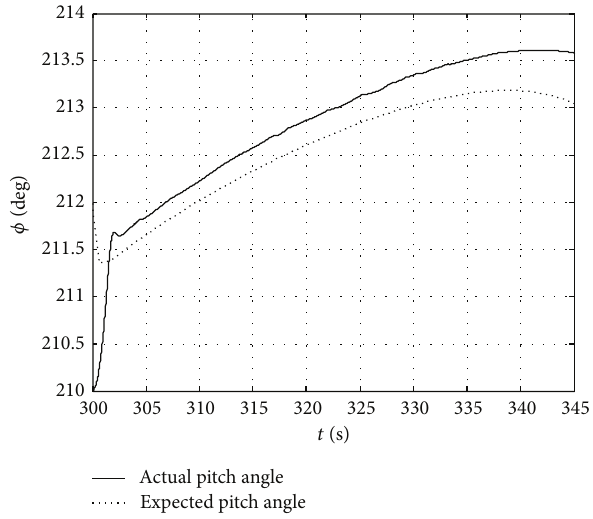
Figure 14: Simulation result of roll angle.